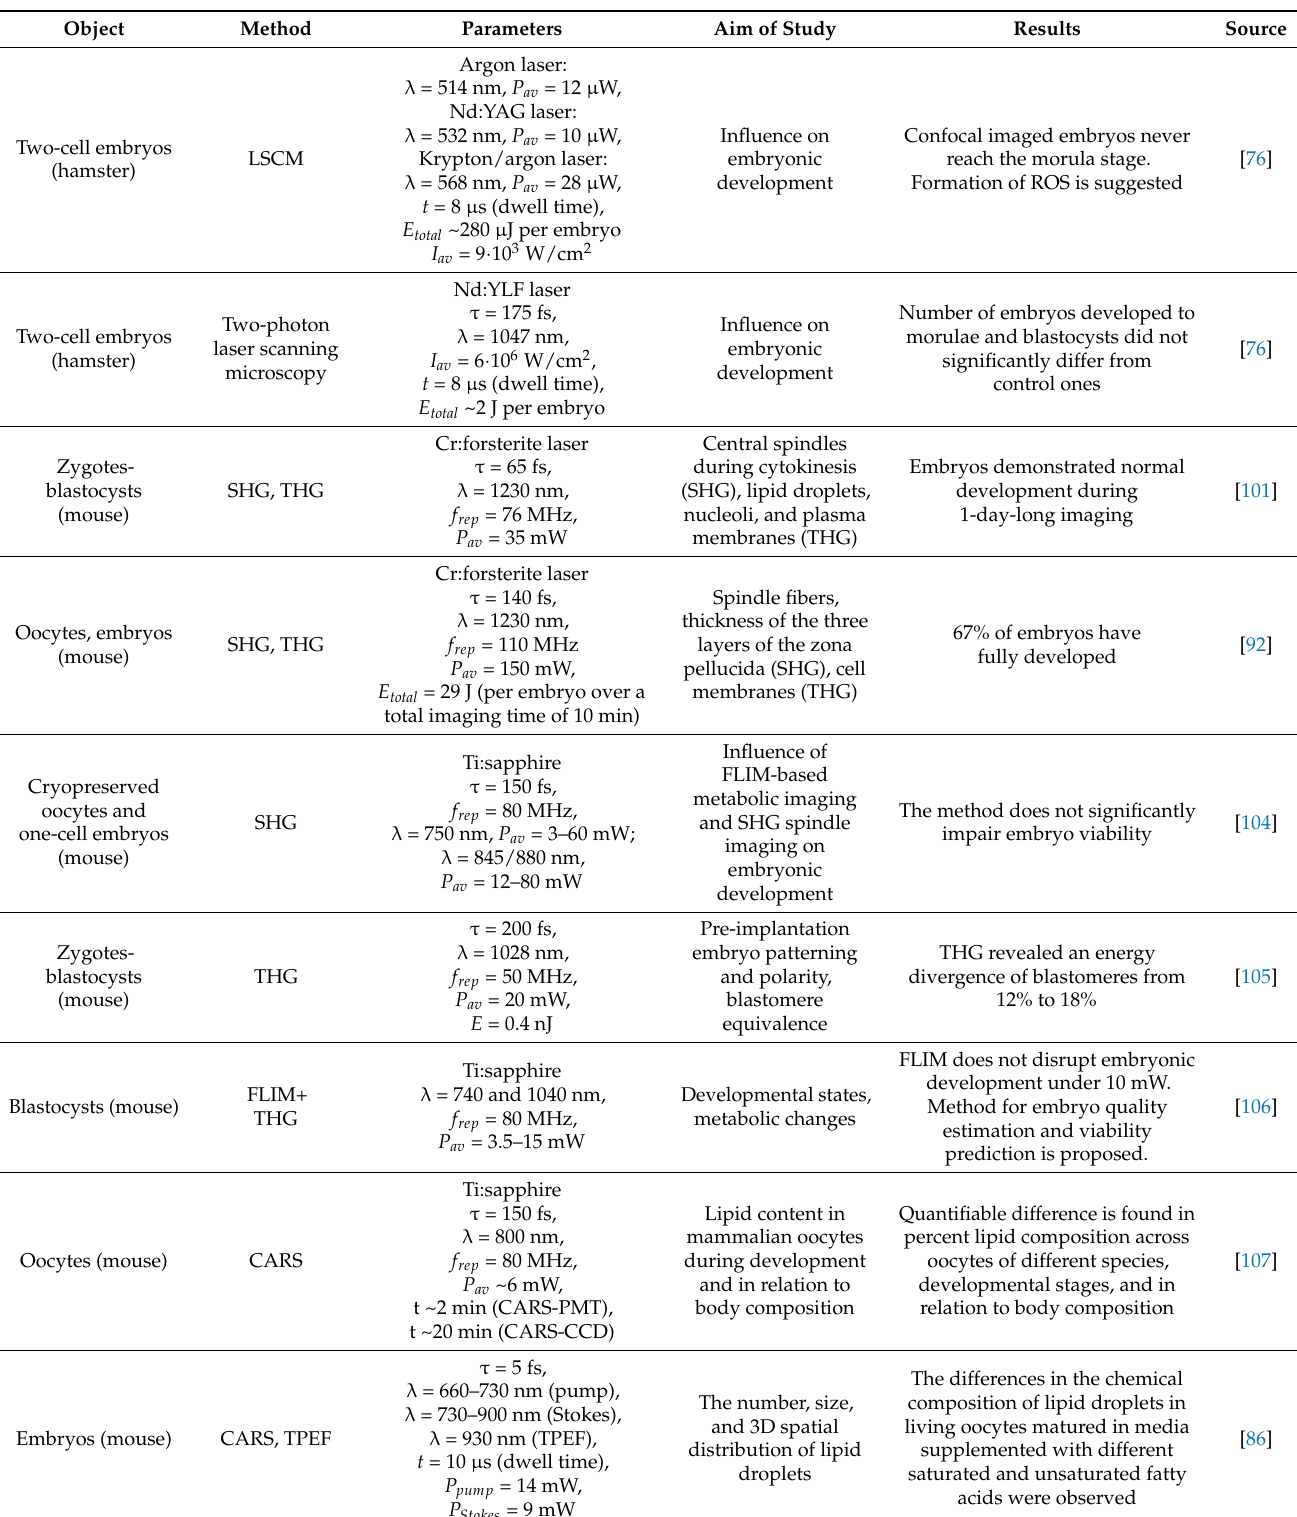
Table 1. NLO microscopy for studying oocytes and